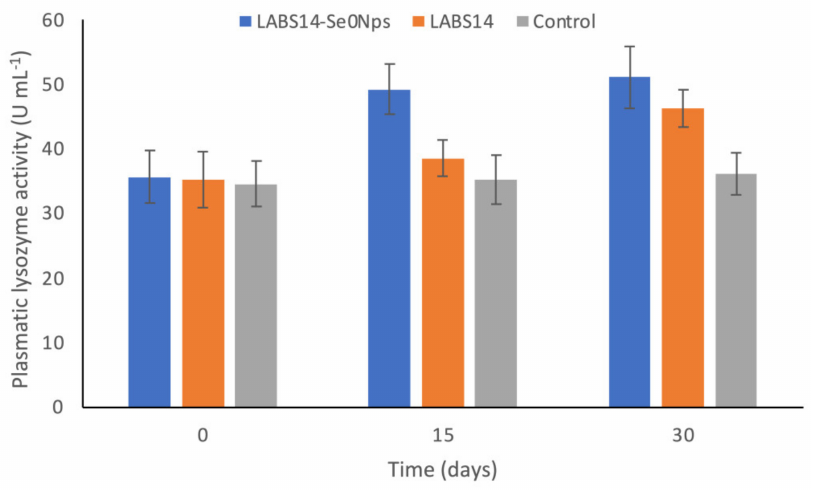
Figure 4. Plasmatic lysozyme activity (U mL − 1 ) in rainbow trout whose food was supplemented, for 30 days, with 108 CFU of Se nanoparticle-enriched Lactiplantibacillus plantarum S14 strain (LABS14- Se 0 Nps) g − 1 or 108 CFU L. plantarum S14 strain (LABS14) g − 1 . Control did not receive the bacterial strain. Bars indicate standard